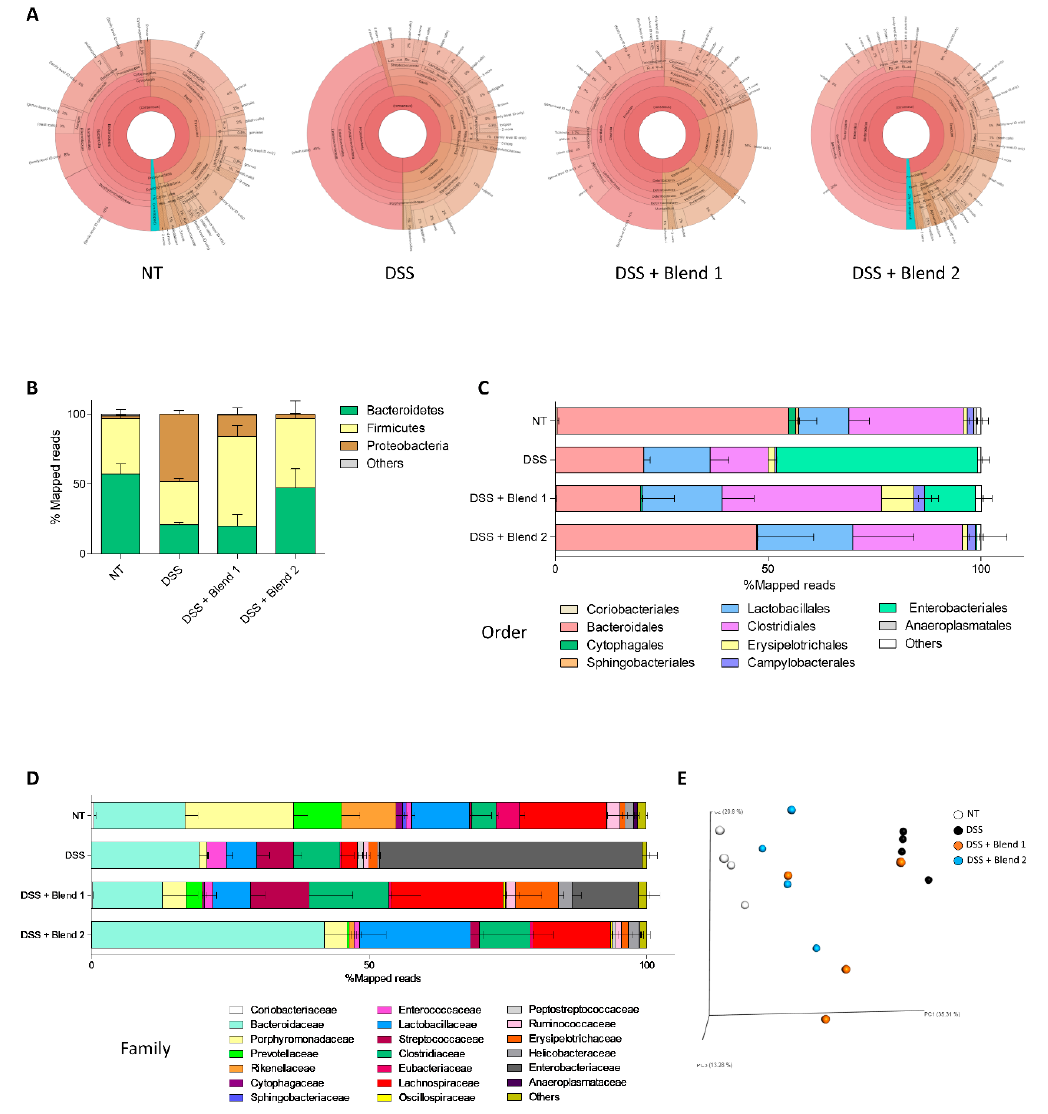
Figure 5. Effects of probiotic formulations on microbiome composition. The experiment was carried out on Balb/c mice. Mice were treated with DSS in drinking water and then administered with vehicle or one of the two formulations of probiotics by gavage from day 0 to day 8. ( A ) The visualization result of 16s analysis with taxonomy components of one representative sample of each group, using the Krona interface. ( B ) The gut microbiota composition profiles at phylum level, expressed as percentage of mapped reads. The gut microbiota composition profiles at order ( C ) and family ( D ) level, expressed as percentage of mapped reads. ( E ) The gut microbiota changes observed in mice differentiated by principal coordinate analysis (PCoA) using the Bray–Curtis dissimilarity matrices. Results are the mean ± SEM of 4 mice per group.